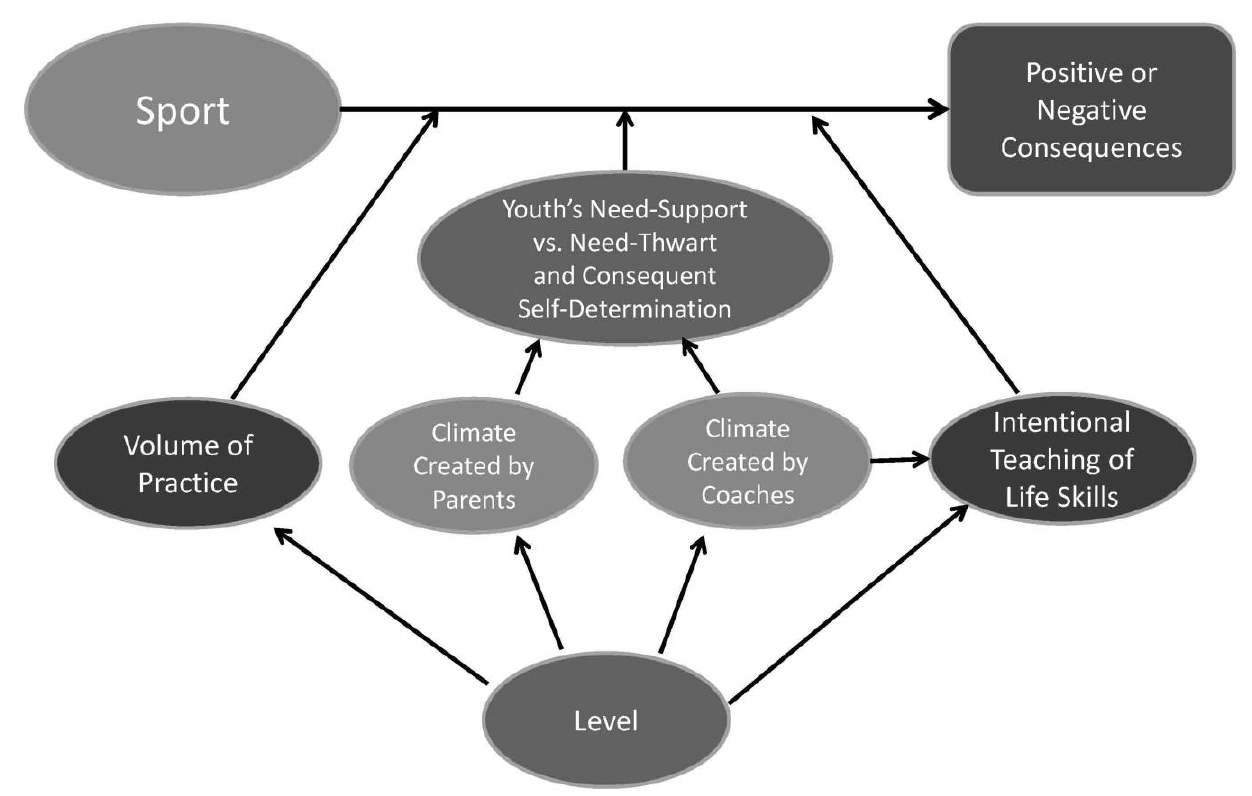
Figure 1. A proposed model to explain under which circumstances sport has a positive or a negative influence on